Question: Write a caption explaining this figure to a reader.
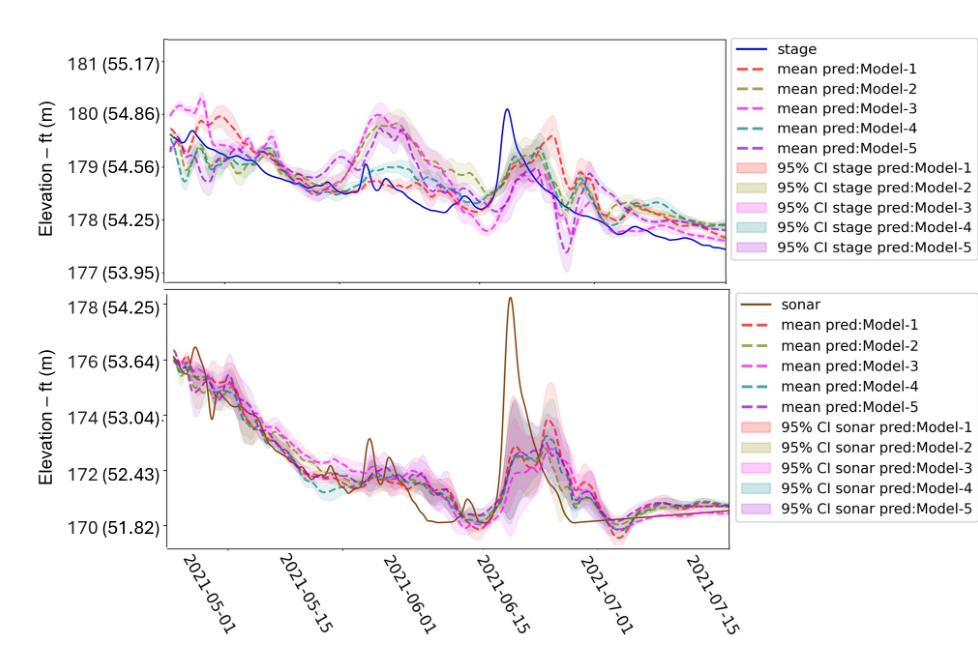
Answer: Stage (top) and Sonar (bottom) predictions of top-5 FCN models. The mean and 95% confidence intervals are considered on the test dataset - Oregon Luckiamute bridge.